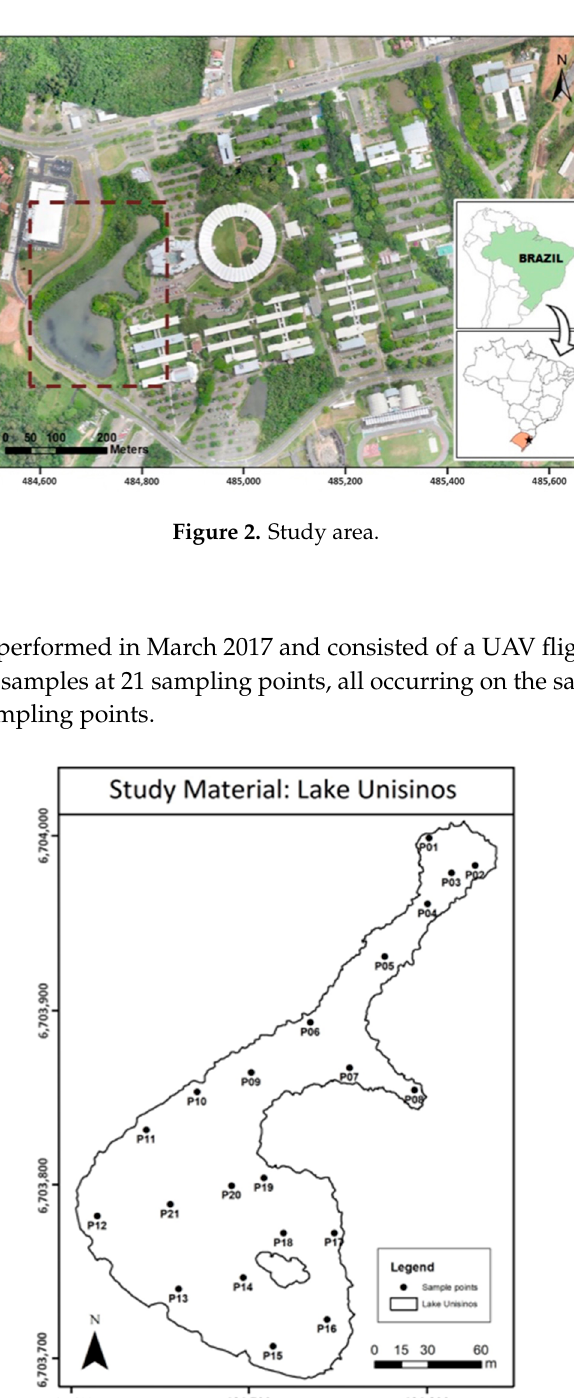
Figure 4. Hexacopter used for lake mapping.